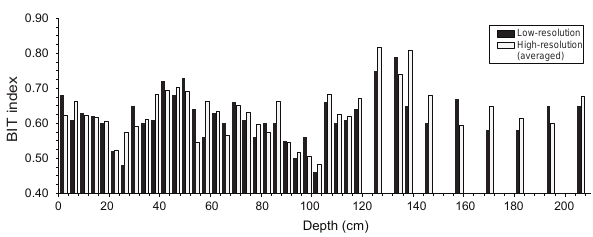
Figure 7. Comparison of BIT index values from our decadal- resolution time series, averaged over four adjacent 1cm sections, against the BIT index measured on integrated 4cm sections of the same sediment core analyzed earlier by Verschuren et al.